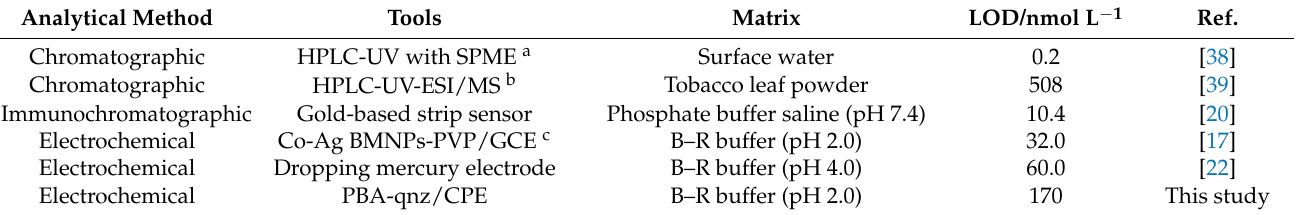
Table 1. Comparison of the performance of different analytical methods in the quantification of